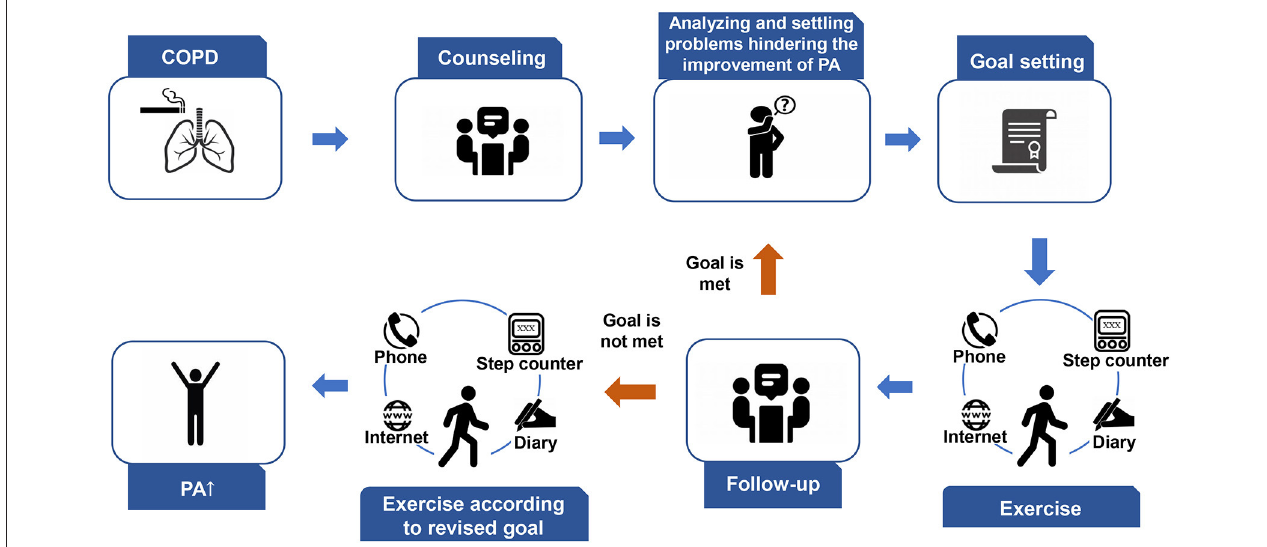
FIGURE 2 | Procedure of step counter-based PA promotion programs of patients with COPD. COPD, chronic obstructive pulmonary disease; PA, physical